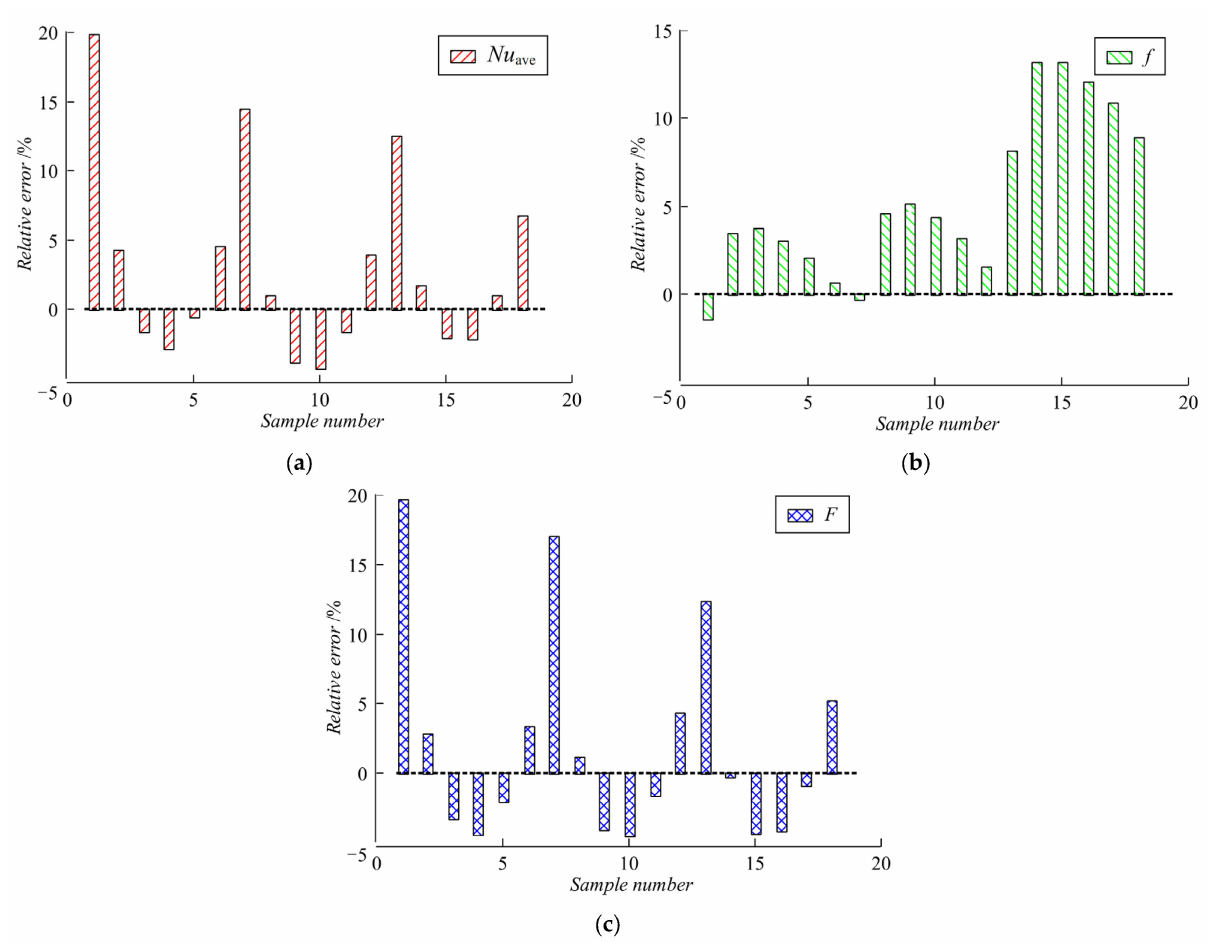
Figure 14. Fitting errors: ( a ) C p ; ( b ) Nu ; ( c ) F